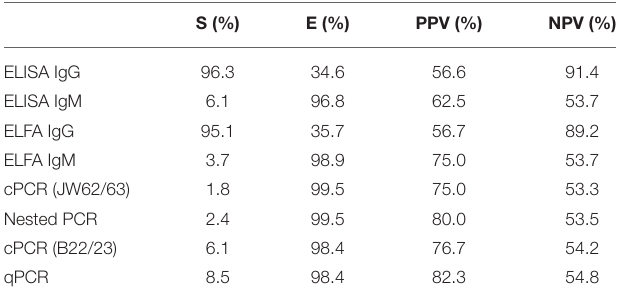
TABLE 2 | Results for sensitivity (S), specificity (E), positive predictive value (PPV), and negative predictive value (NPV) between the serological tests in G1 and G2, performed by ELISA (DiaSorin) and ELFA (Biomerieux) and between the molecular tests performed by cPCR (JW62/63), Nested PCR, cPCR (B22/23), and